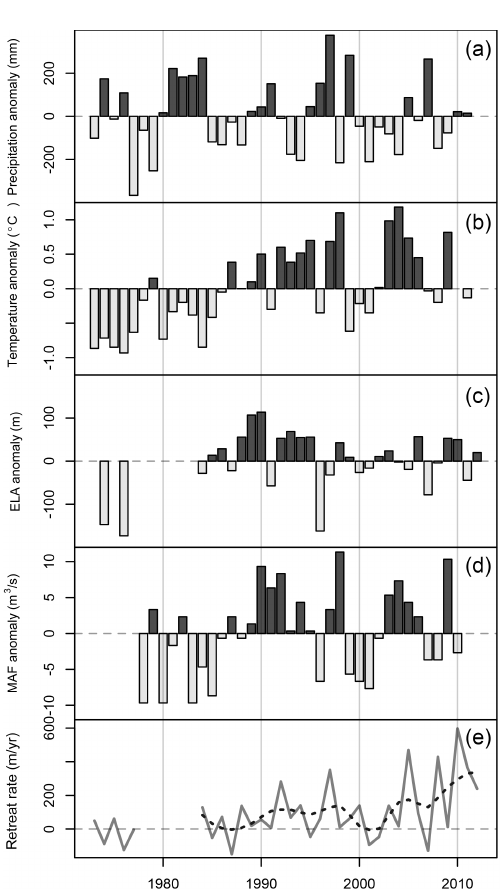
Figure 7. Summary of climatic indicators and glacier response: (a) Vancouver winter precipitation anomaly ( x = 819mm), (b) Van- couver summer temperature anomaly ( x = 14.8 ◦ C), (c) equilib- rium line altitude ( x = 2089m), (d) Bridge River mean annual flow anomaly ( x = 10.7m 3 s − 1 ), and (e) annual retreat rate (myr − 1 ), where the dashed line is loess-smoothed retreat (span =